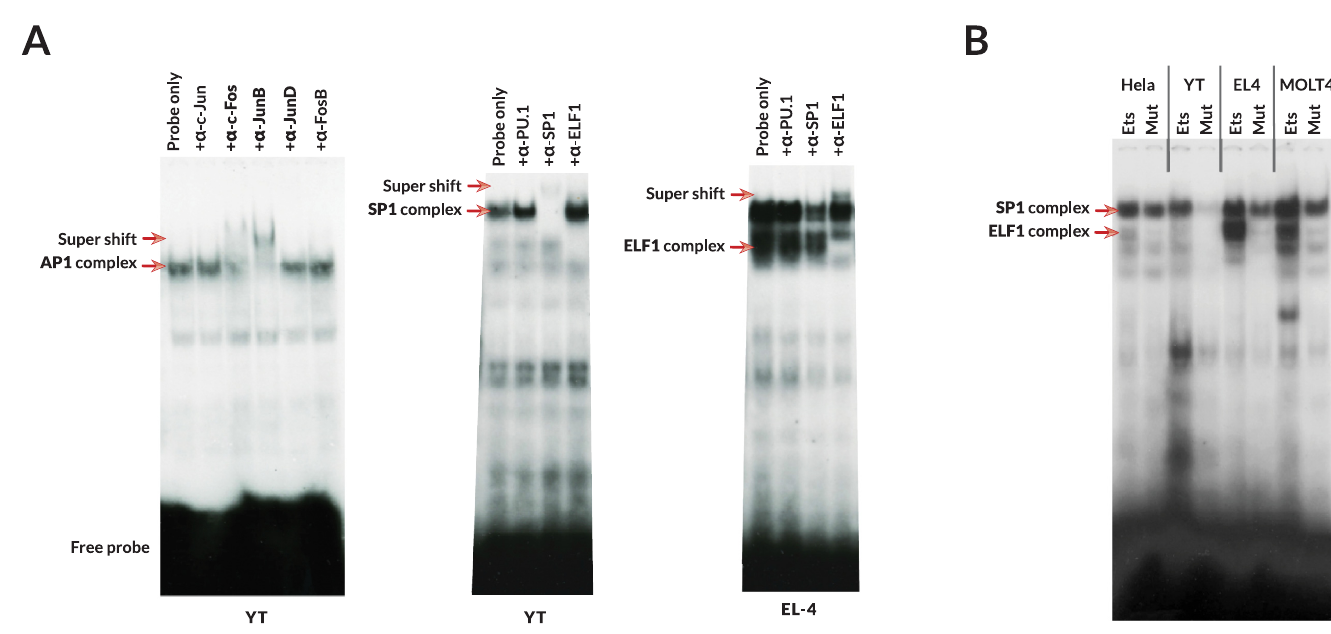
Fig 6. Binding of Fos/Jun and SP1/Elf to the NK-Pro elements. (A) EMSA performed with probes spanning either the AP1 or SP1/Ets sites of the HLA-C NK-Pro. The first panel shows results obtained using the AP1 probe with YT cell nuclear extracts. Inhibition of complex formation or supershift by various anti-Fos or Jun antibodies is shown. The middle panel shows results obtained with the SP1/Ets probe and YT extract, and the right panel shows complexes formed in EL4 extract. Inhibition of complex formation or supershift by anti-SP1 or Elf-1 antibodies is shown. (B) Comparison of TF binding to SP1/Ets probes containing either the wt (Ets) or mutant (Mut) Ets sites. Probe binding to nuclear extracts from HeLa, YT human NK cell, EL4 mouse T cell, and MOLT4 human T cell lines are shown.